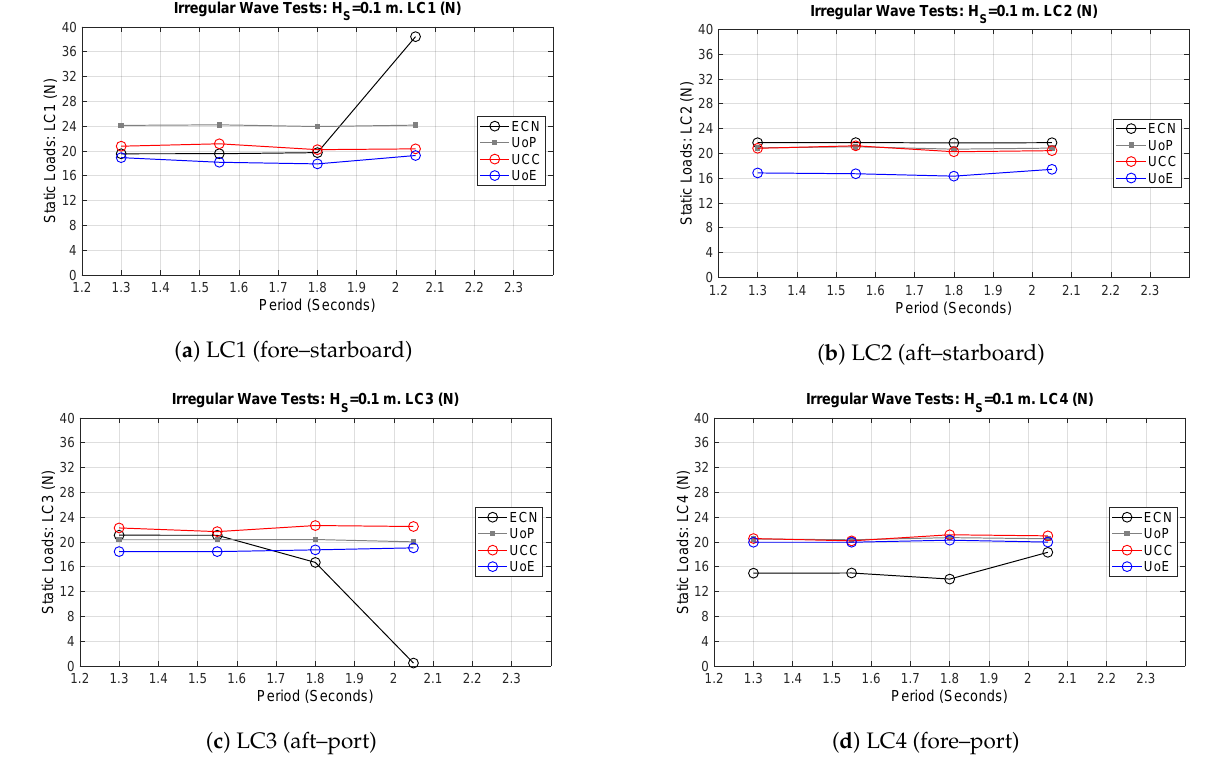
Figure 8. Load cell static loads for H s of 0.1 m across facilities.